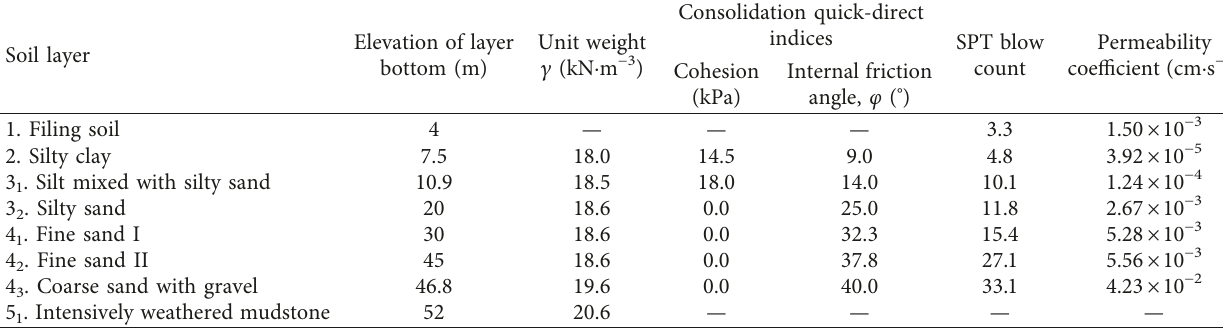
Table 1: Physical and mechanical indices of soil layers.